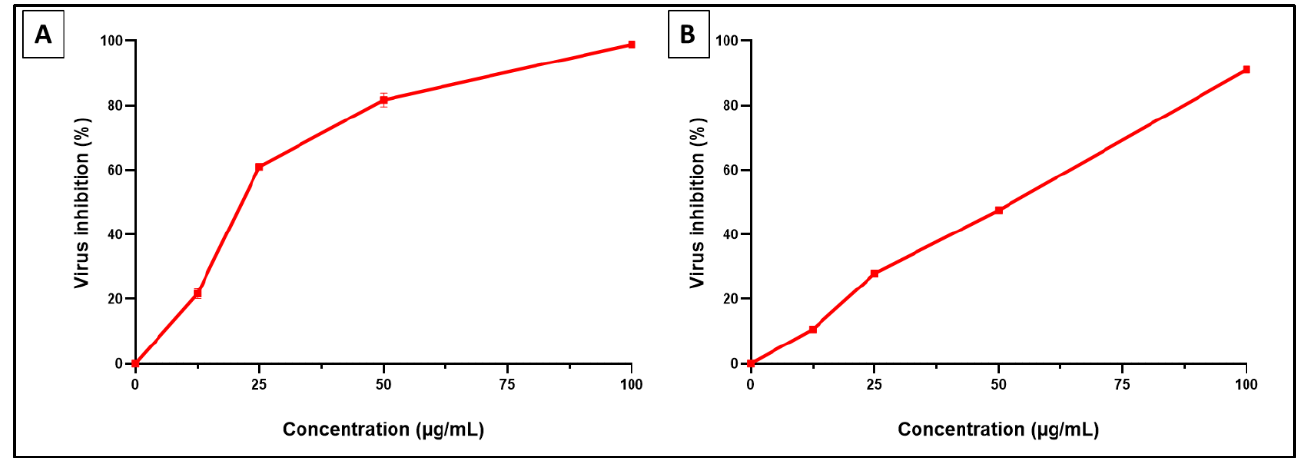
Figure 3. Antiviral activity of Saussurea costus roots on ( A ) low pathogenic human coronavirus (HCoV-229E) (with IC 50 of 23.21 ± 1.1 µg/mL) and ( B ) human influenza virus H1N1 (with IC 50 of 47.6 ± 2.3 µg/mL). Results are shown as mean ± SD.